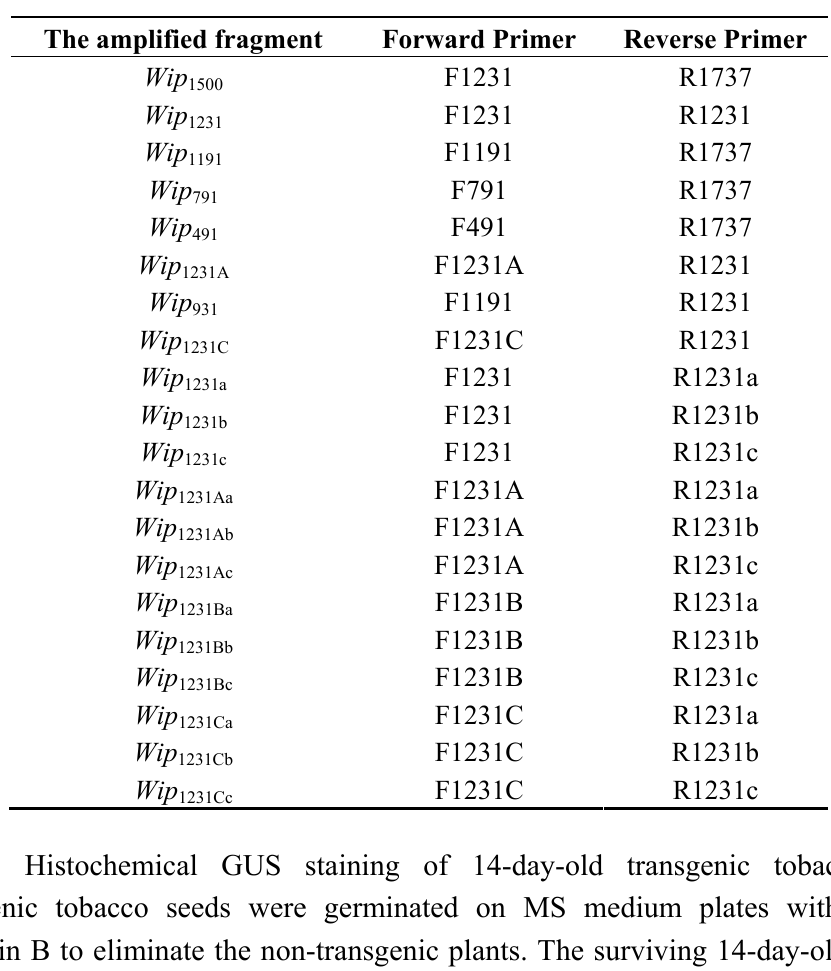
Table 2. The primers used to amplify different truncated promoters.